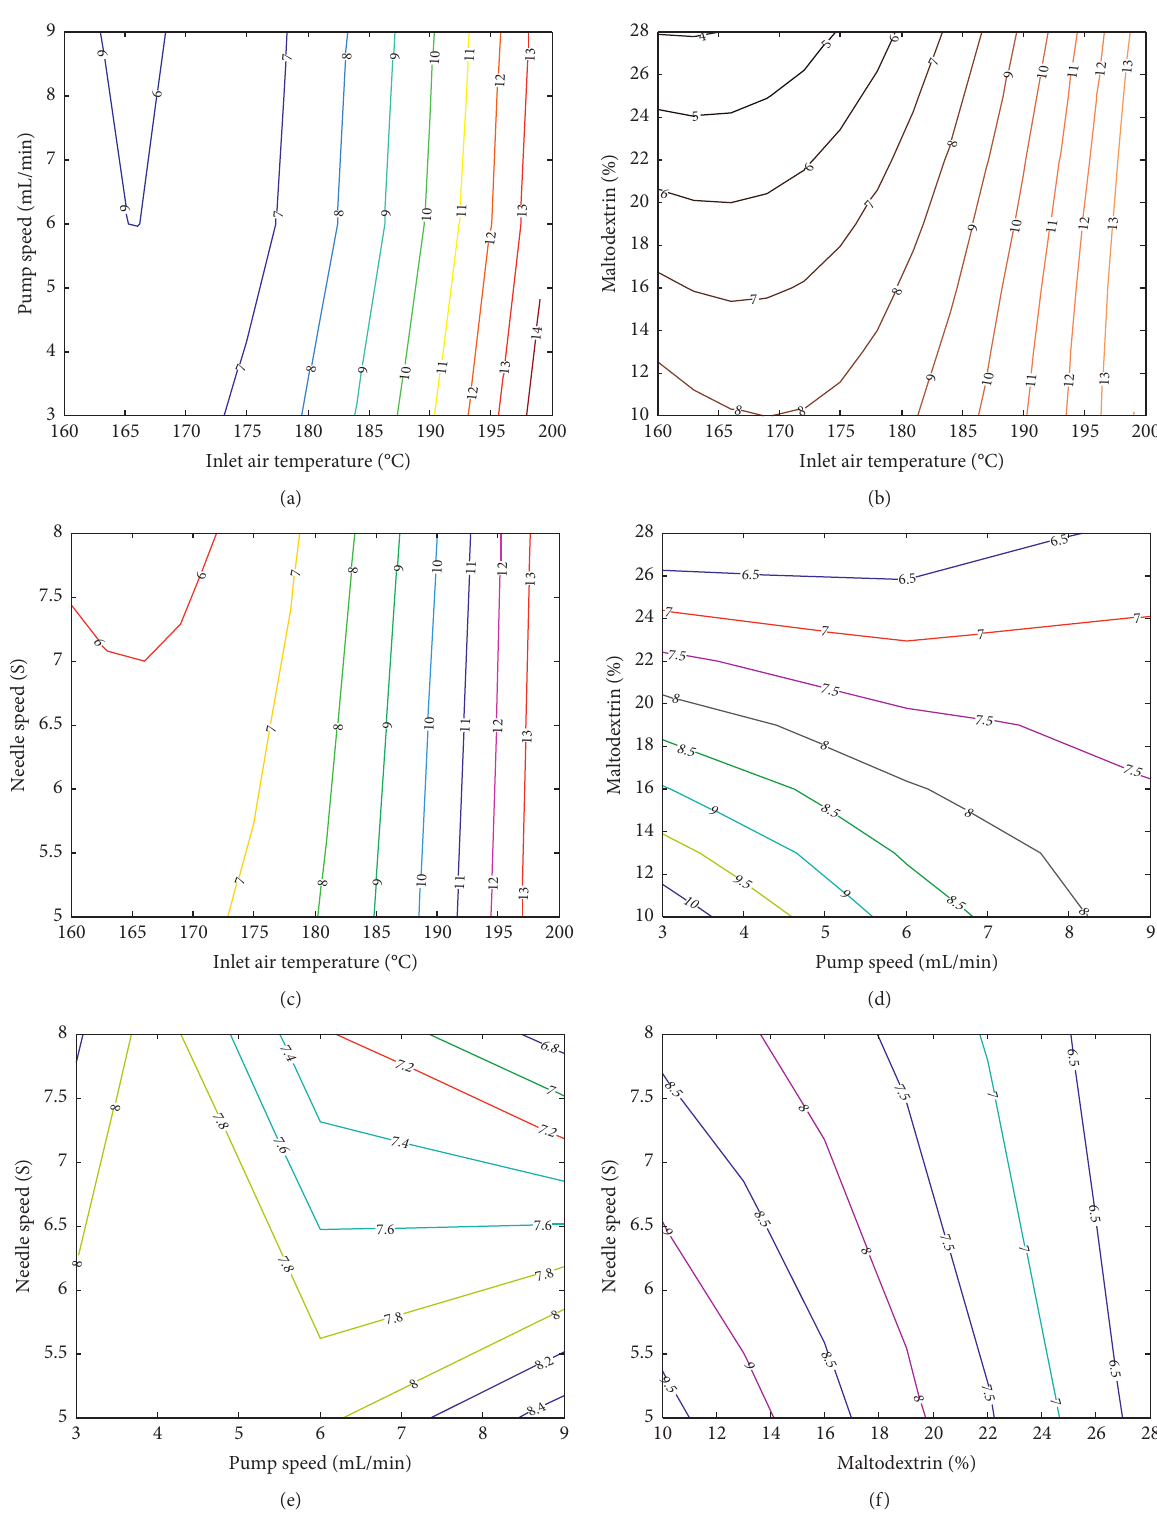
Figure 3: The mutual interaction impact of spray drying conditions on percent EPA